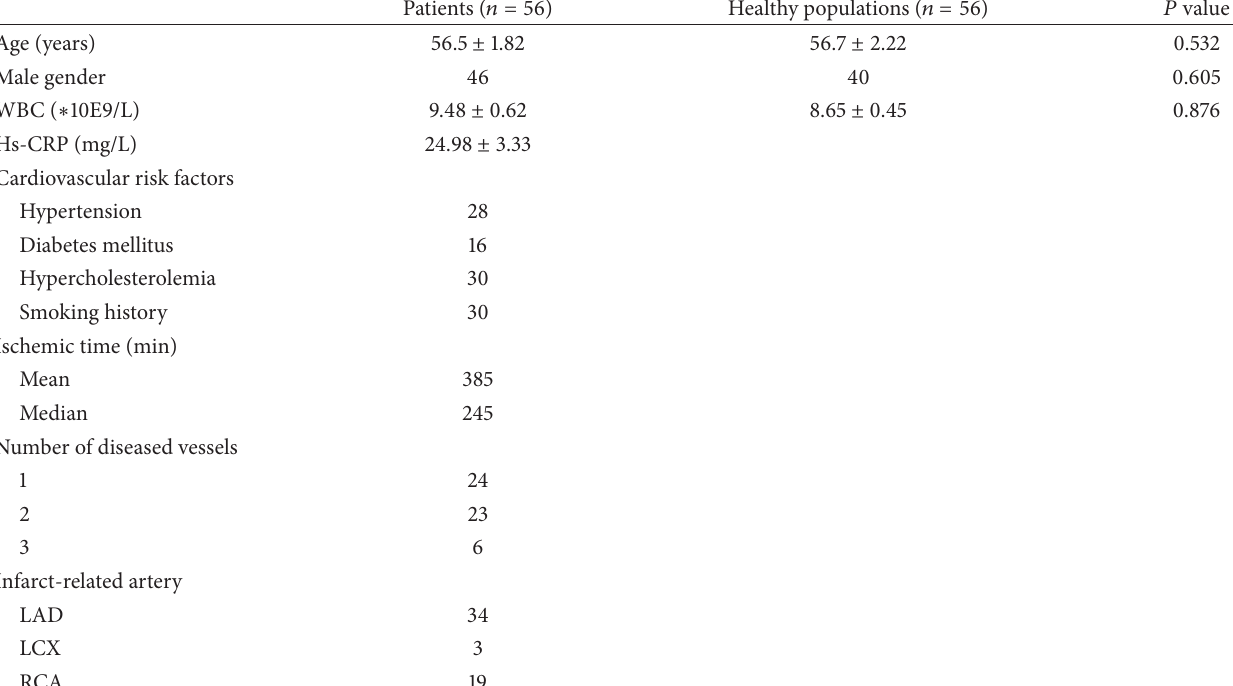
Table 1: Baseline characteristics of healthy volunteers and patients with ASTEMI after PCI.